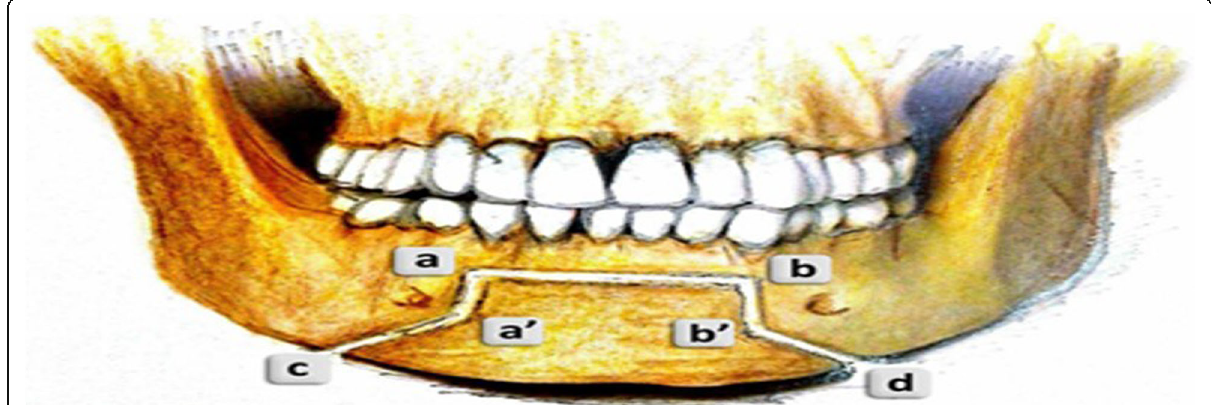
Fig. 1 Schematic frontal view of cutting lines of Balcony technique